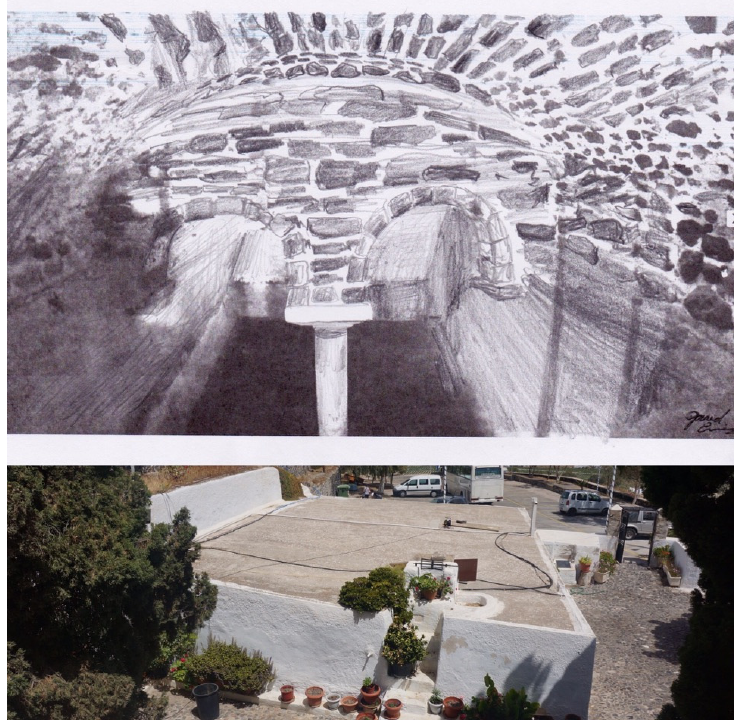
Figure 4. Interior ( top ) and well access ( bottom ) of the cistern at Panagia Episkopi. Illustration and photography by Jared Enriquez.